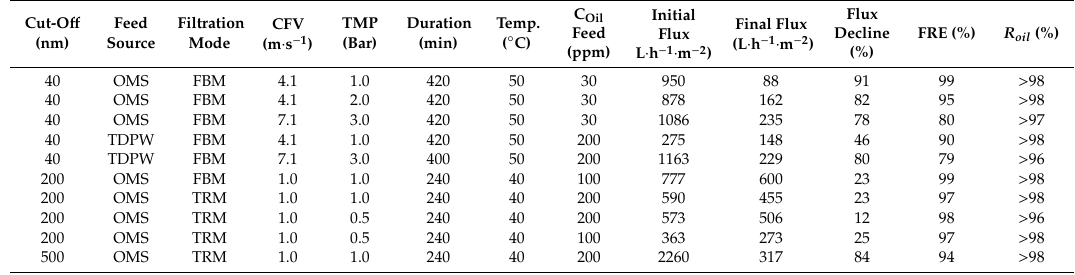
Table 5. Selected flux and oil retention data for SiC MF and UF membranes.